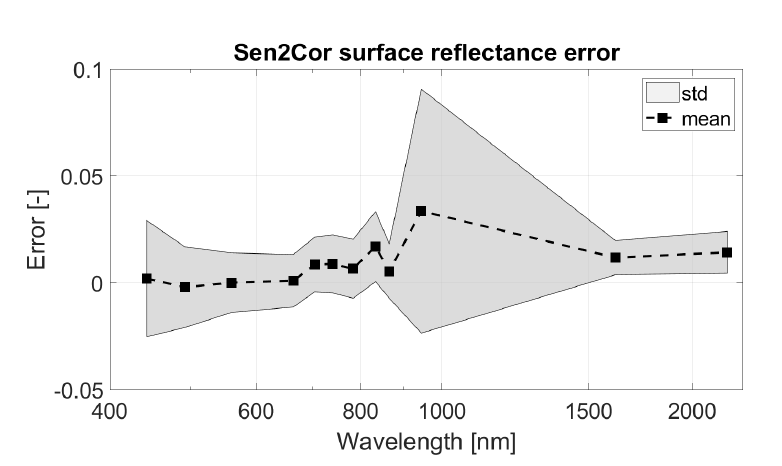
Figure 4. Typical error in surface reflectance after Sen2Cor atmospheric correction algorithm. See Table VIII in [50] for detailed